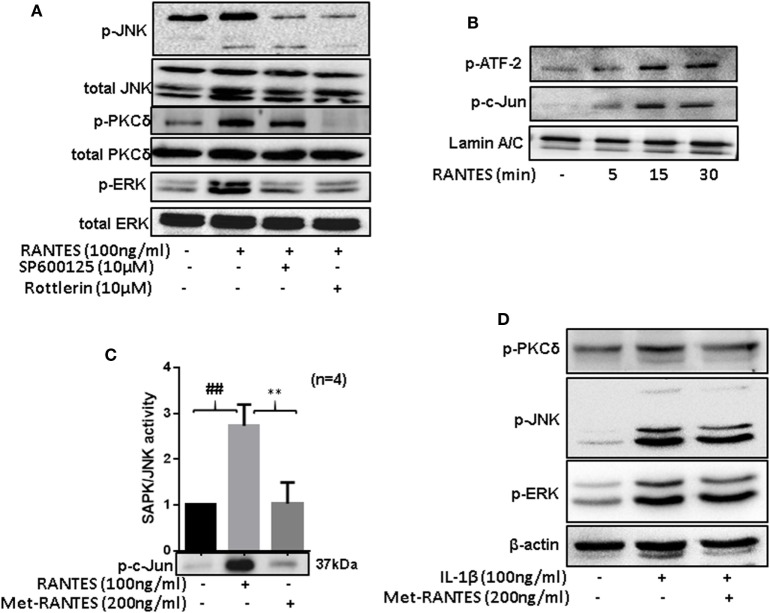
Regulated on activation, normal T expressed, and secreted (RANTES)/CC ligand 5 (CCL5)-mediated phosphorylation of PKCδ causes JNK and ERK activation to induce matrix metalloproteinase (MMP)-1 and MMP-13 production in rheumatoid arthritis synovial fibroblasts (RASFs). (A) RASFs were pretreated with the inhibitor of JNK (SP 600125; 10 µM) or PKCδ (Rottlerin; 10 µM) for 2 h followed by RANTES/CCL5 stimulation (100 ng/ml) for 30 min to determine the hierarchy of signaling proteins (p-PKCδ, p-JNK, and p-ERK) in RANTES/CCL5-mediated signal transduction using Western immunoblotting. (B) Effect of RANTES/CCL5 on nuclear translocation of p-ATF-2 and p-c-Jun in RASFs was determined using Western immunoblotting. RASFs were stimulated with RANTES/CCL5 (100 ng/ml) for 5, 15, and 30 min and nuclear fraction were used to study the effect on p-ATF-2 and p-c-Jun. Lamin A/C was used as loading control. (C) Effect of Met-RANTES on RANTES/CCL5 induced SAPK/JNK activity in RASFs. RASFs were pretreated with Met-RANTES for 30 min followed by RANTES/CCL5 treatment for 30 min. Immunoprecipitation was performed using p-SAPK/JNK antibody and antagonizing effect of Met-RANTES was determined by Western immunoblotting. Densitometry was performed to show the relative changes in SAPK/JNK activity and values are represented as mean ± SE from independent experiments performed on RASFs obtained from different donors. (D) RASFs were pretreated with Met-RANTES for 30 min followed by IL-1β treatment for 30 min. Cell lysates were used for the detection of p-PKCδ, p-JNK, and p-ERK. ##p < 0.01 NS vs. RANTES/CCL5; **p < 0.01 RANTES vs. RANTES + Met-RANTES.